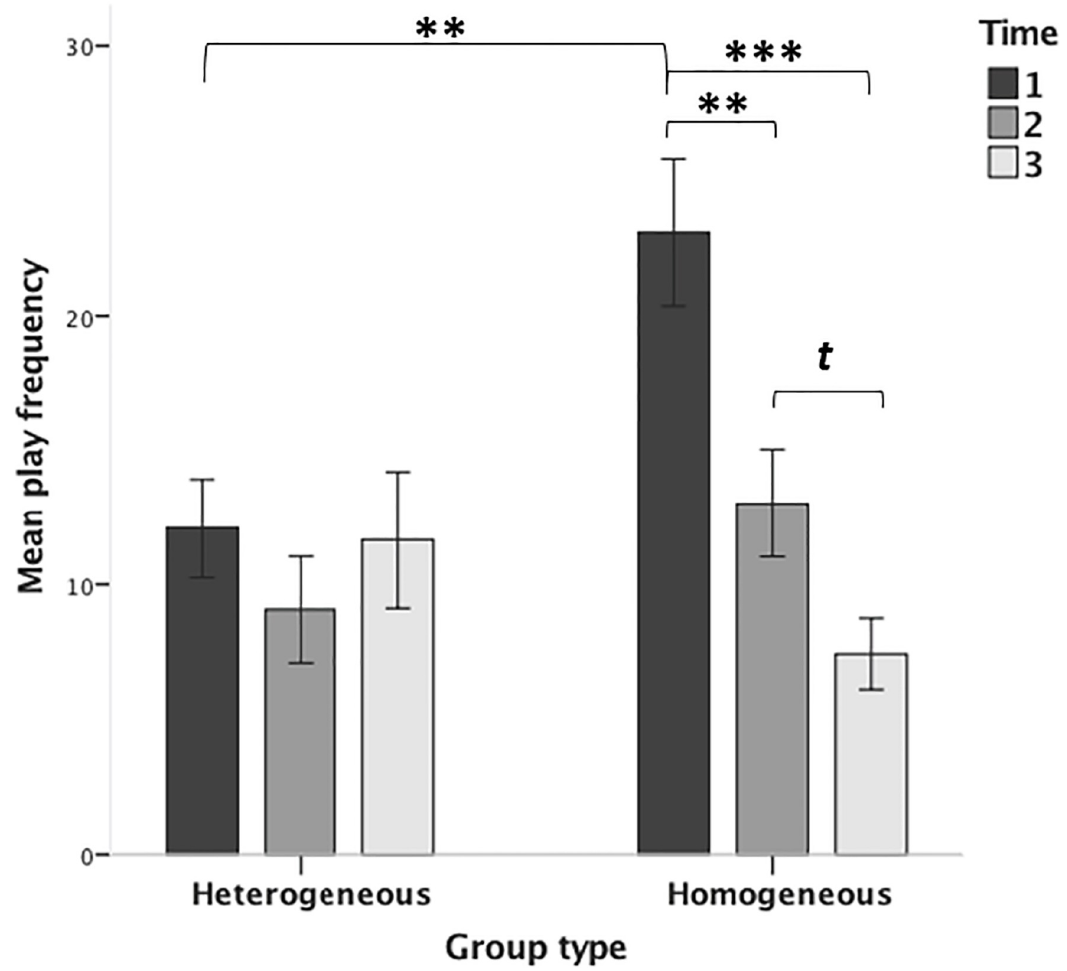
Fig 4. Histograms showing home cage play levels (pinning frequency) across treatment group types (heterogeneous vs. homogenous) and time; given are means and S.E.M.s. Brackets indicate differences between time points ( t : p < 0.1; � : p < 0.05; �� : p < 0.01; ��� : p <